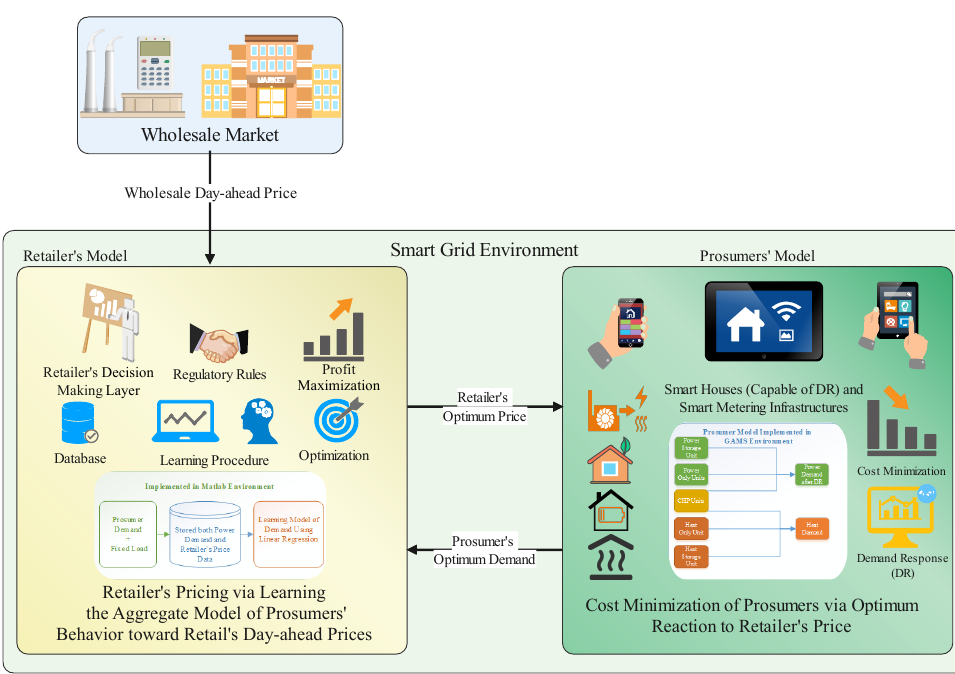
Figure 1. A proposed trading framework for retailer–prosumer